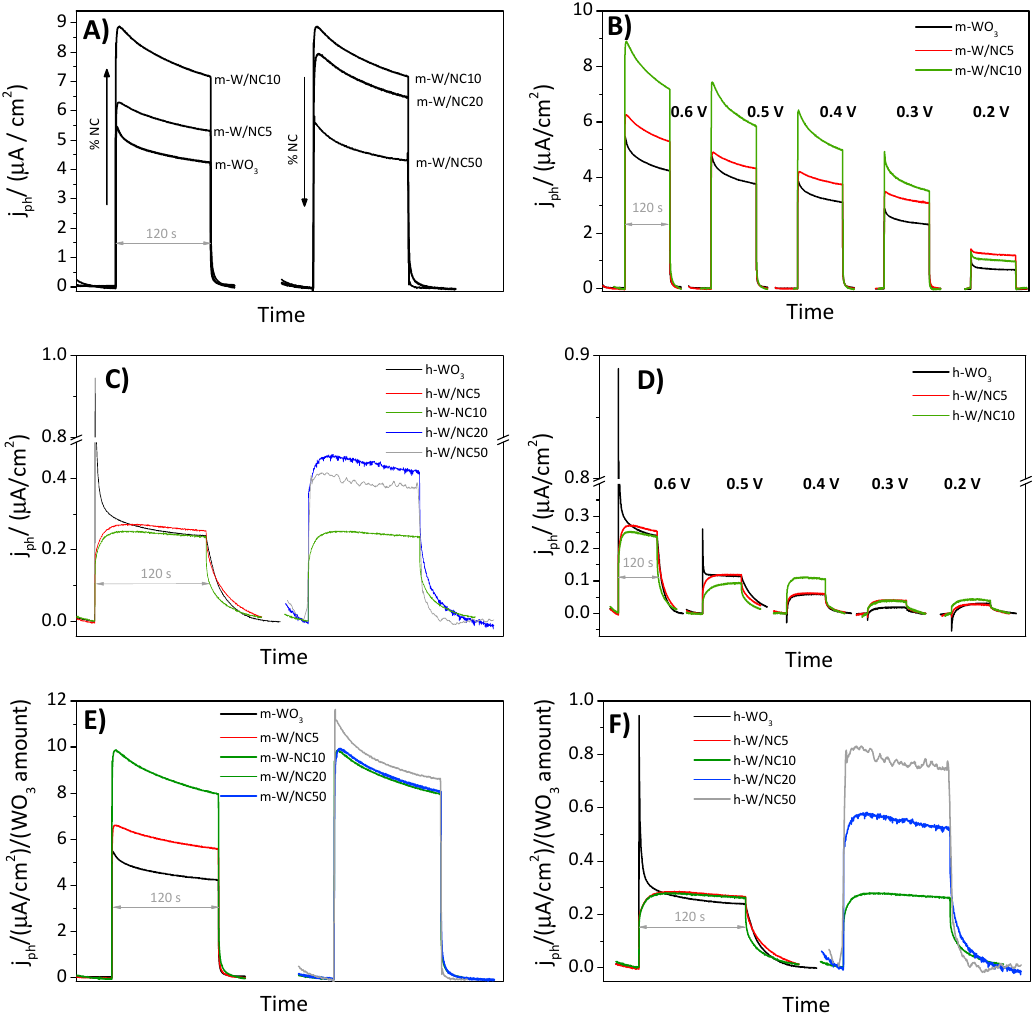
Figure 5. ( A – D ) Transient photocurrent responses under illumination (2 min) at 371 nm of the prepared WO 3 , and WO 3 /carbon electrodes at various bias potentials; ( E , F ). Transient photocurrent responses normalized vs. the amount of WO 3 in the electrodes.